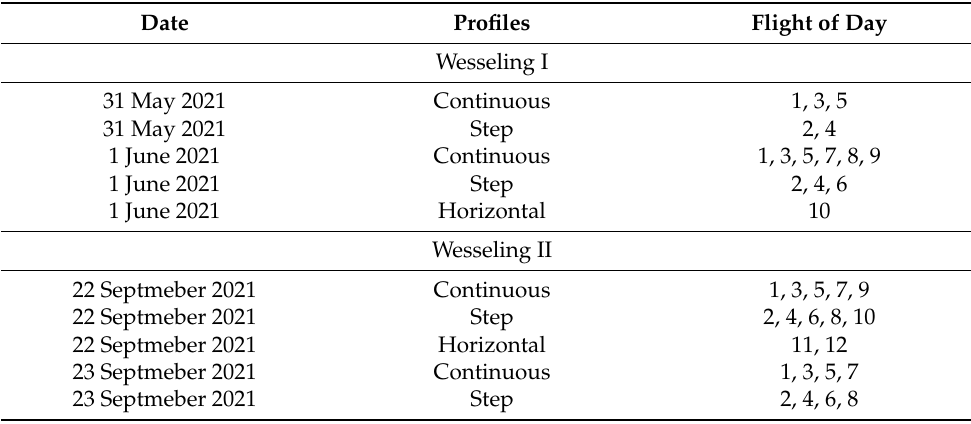
Table 5. Campaign overview of flights and